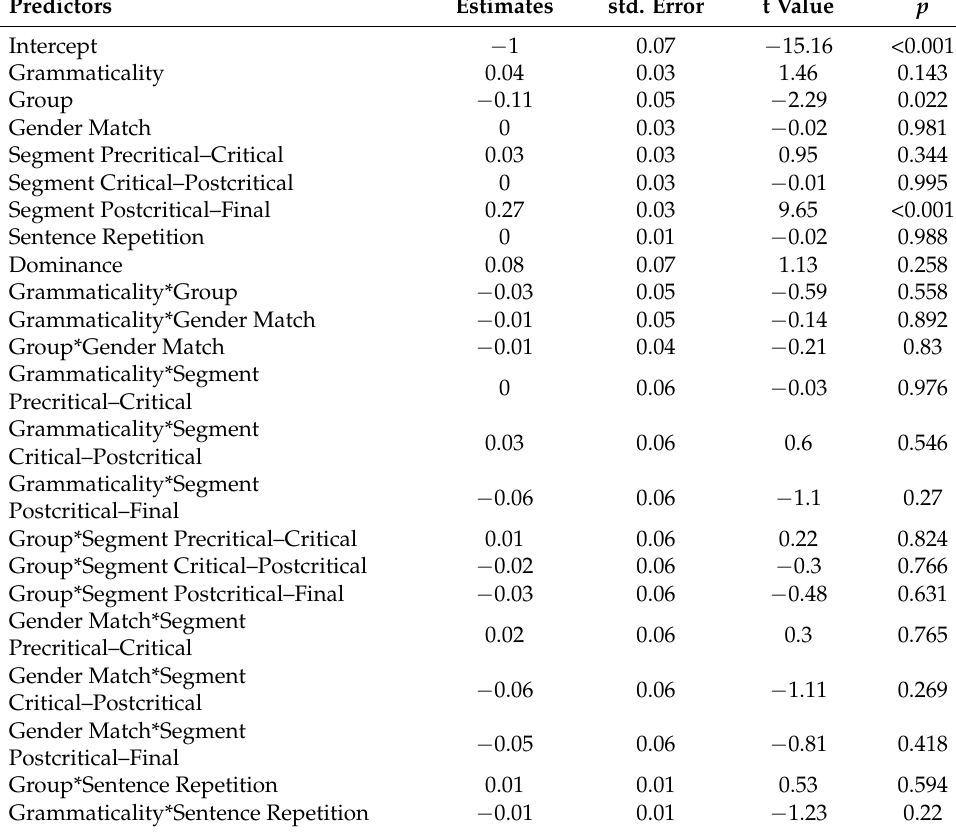
Table A15. Summary of the model with the bilingual children and sentence repetition and dominance as